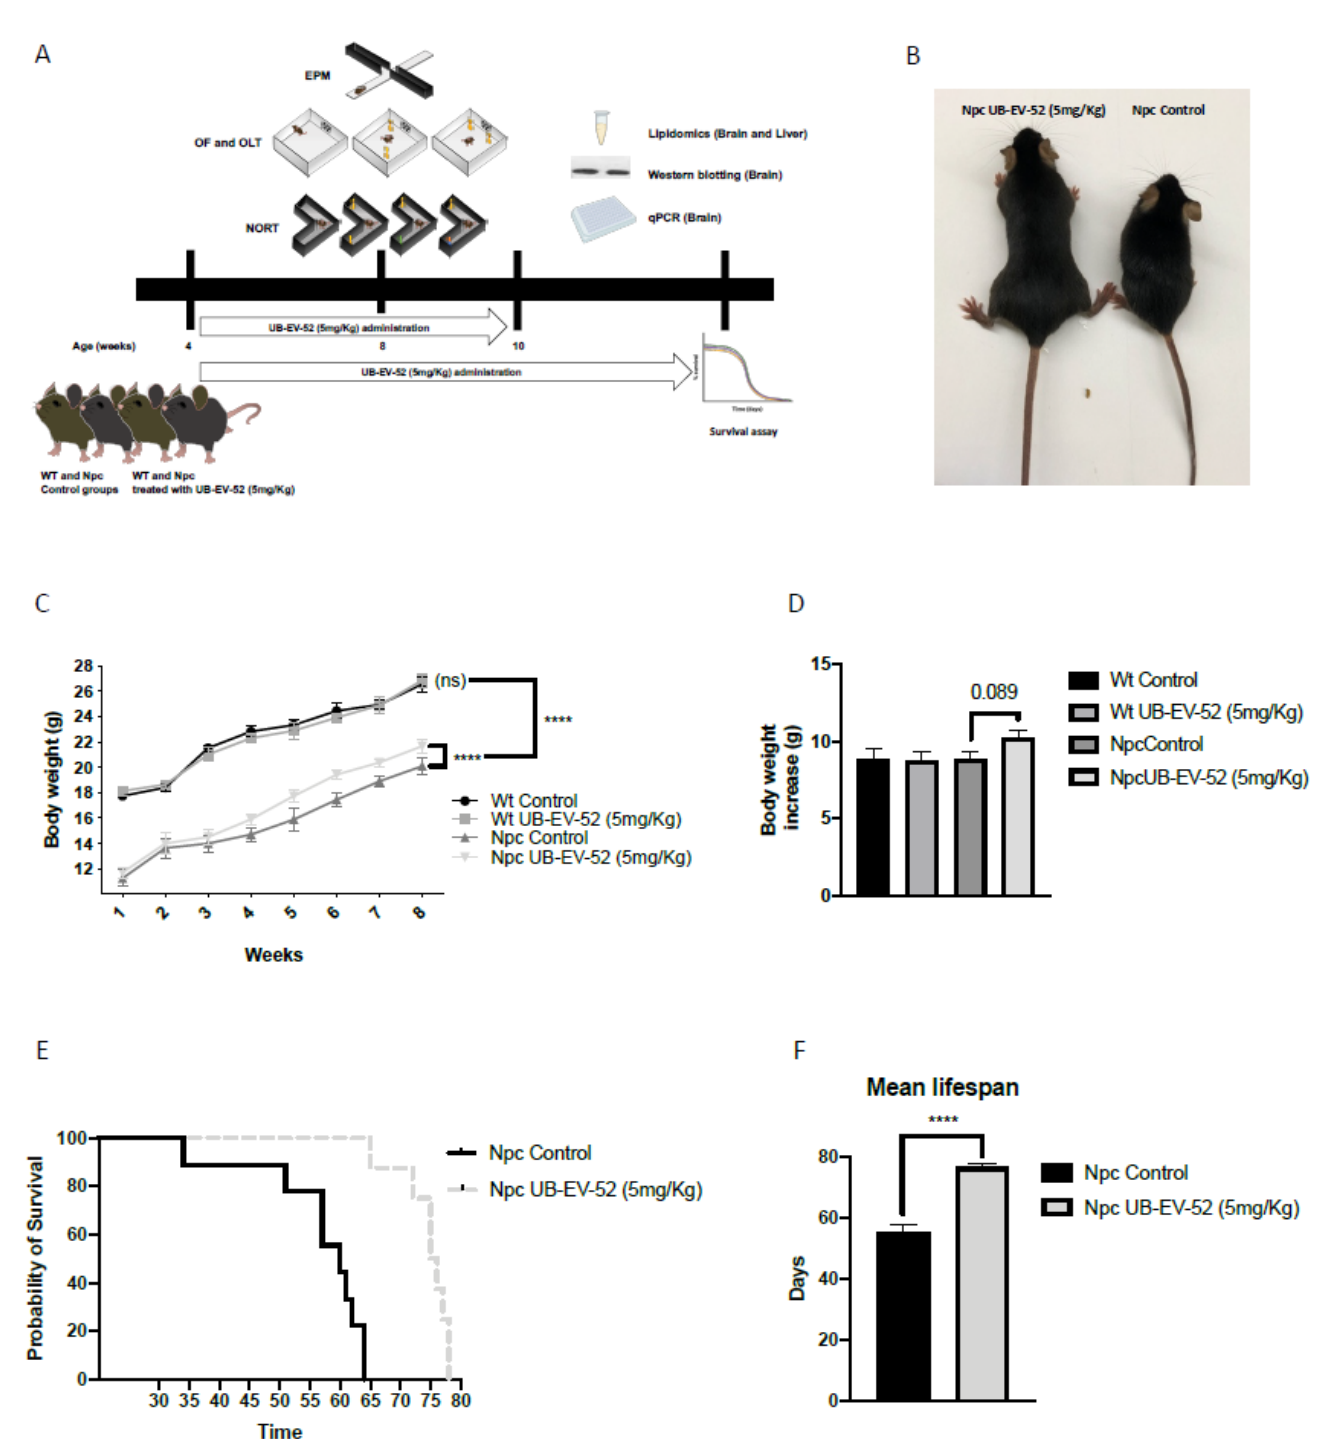
Figure 1. Schematic of experimental design ( A ), mouse phenotype ( B ), body weight curve results in females and males ( C ), total body weight gain results in females and males ( D ), survival curve in females and males ( E ), average lifespan in females and males ( F ). Values represented are mean ± standard error of the mean (SEM); n = 48 (wild-type (Wt) control n = 12, Wt UB-EV-52 (5 mg/kg) n = 12, Niemann–Pick type C (Npc) control n = 12, and Npc UB-EV-52 (5 mg/kg) = 12). **** p < 0.0001.